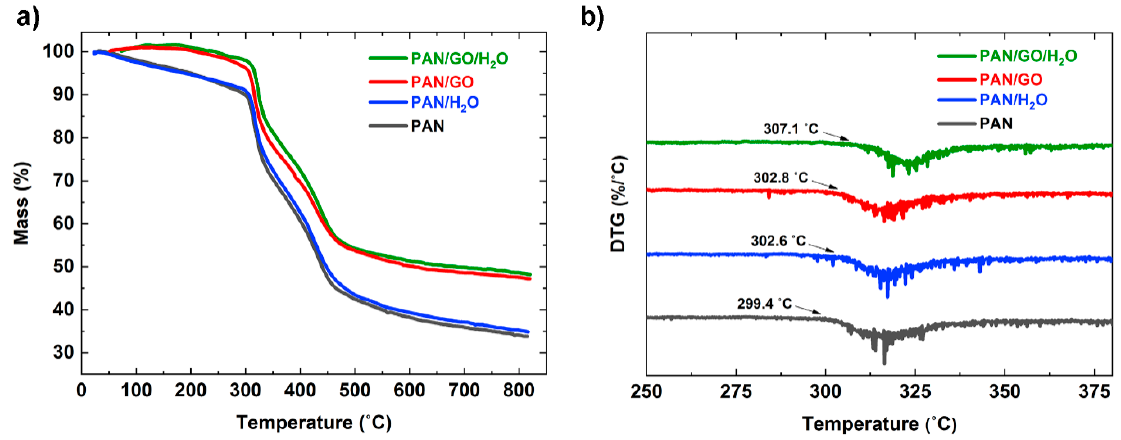
Figure 7. ( a ) TGA and ( b ) DTG curves of PAN-based fibers. Table 3. Thermal properties of PAN-based fibers calculated from TGA and DTG curves.